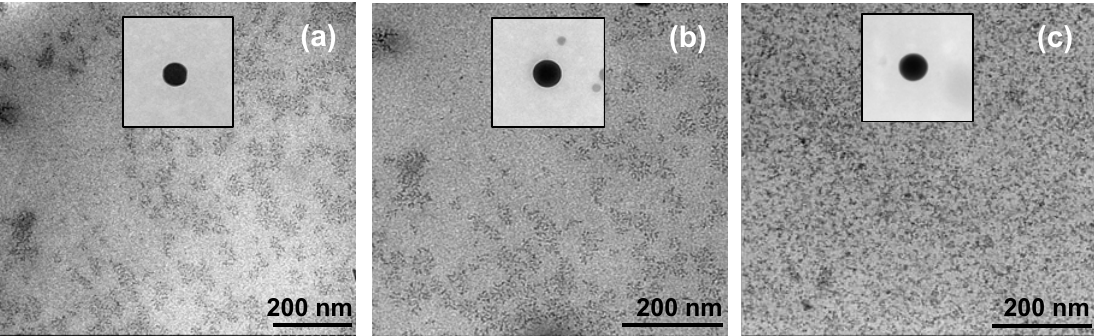
Figure 13. TEM micrographs at 100 kv of ceria nanoparticles derived